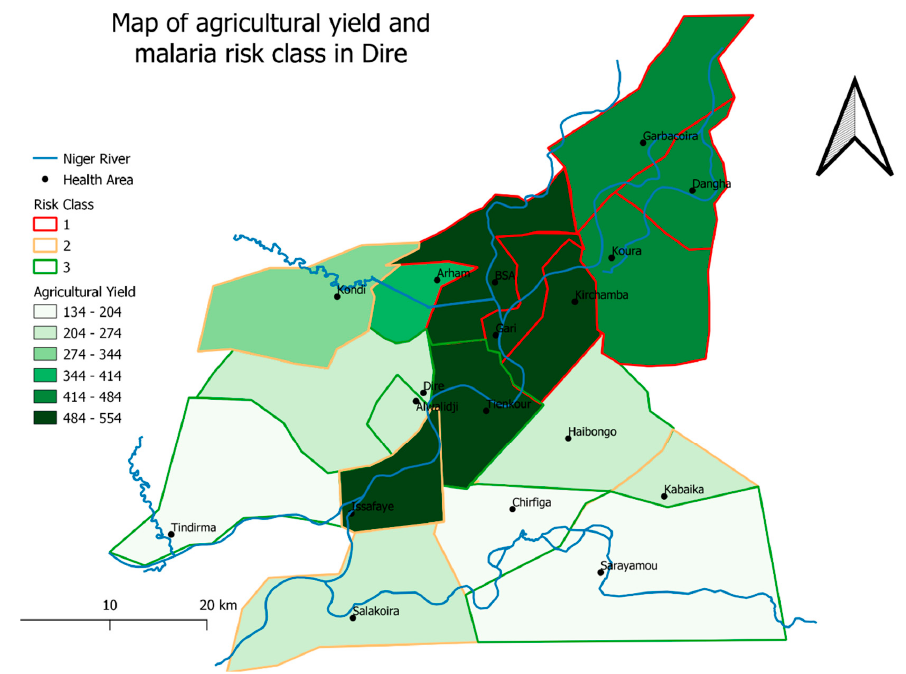
Figure 5. Map of agricultural yield and risk classes in Dire health district.